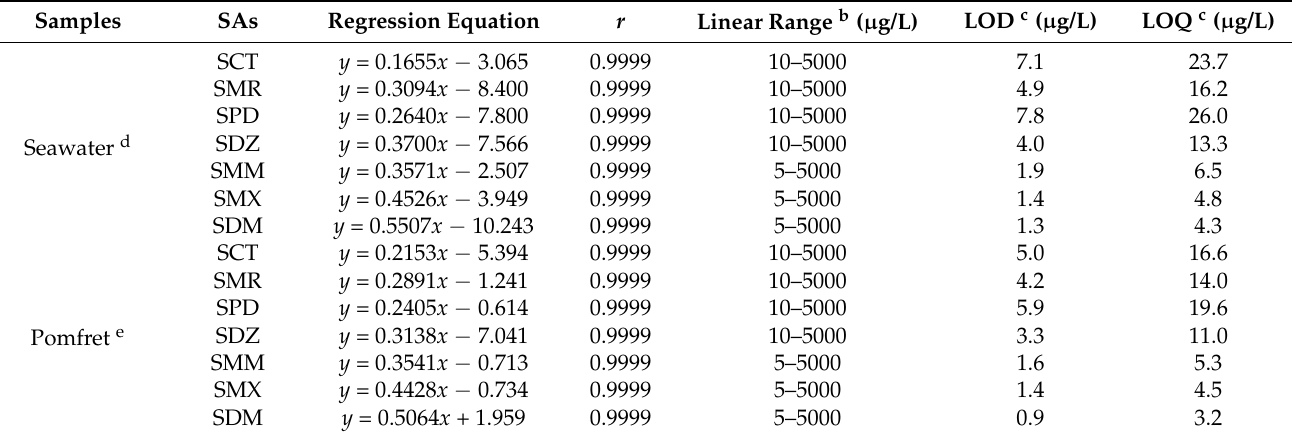
Table 1. Analytical performances of the UA-DLLME-HPLC-DAD method for the determination of seven SAs in seawater and pomfret samples a